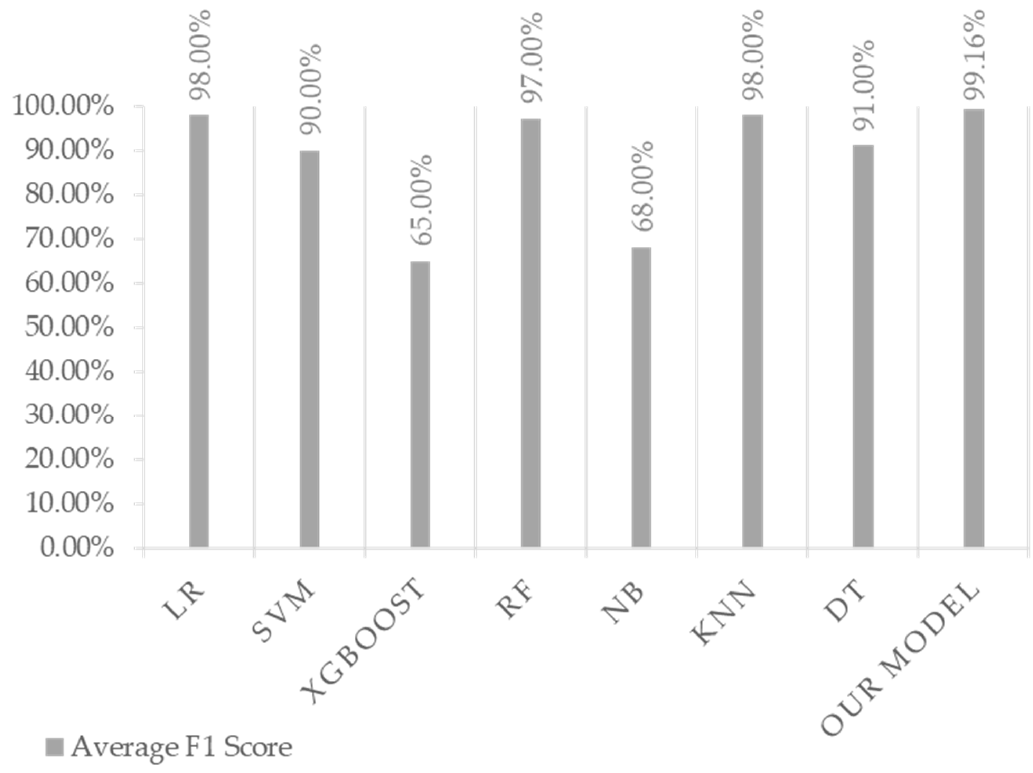
Figure A3. Comparison of the F1 score of our model with different algorithms.